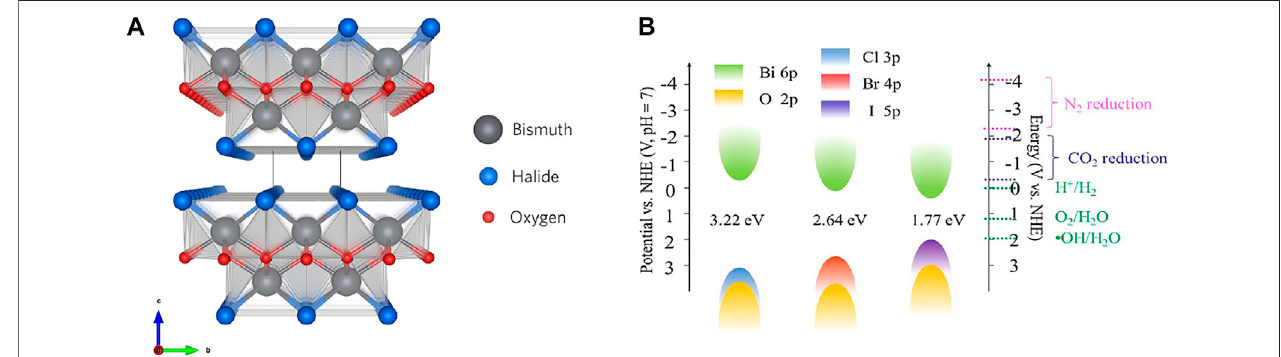
FIGURE2|(A) CrystalstructuresofBiOX(X=Cl,Br,I)(modi fi edwithpermission(Ganoseetal.,2016)). (B) SchematicVBandCBstructuresofBiOX(datafromRef (Guo et al.,